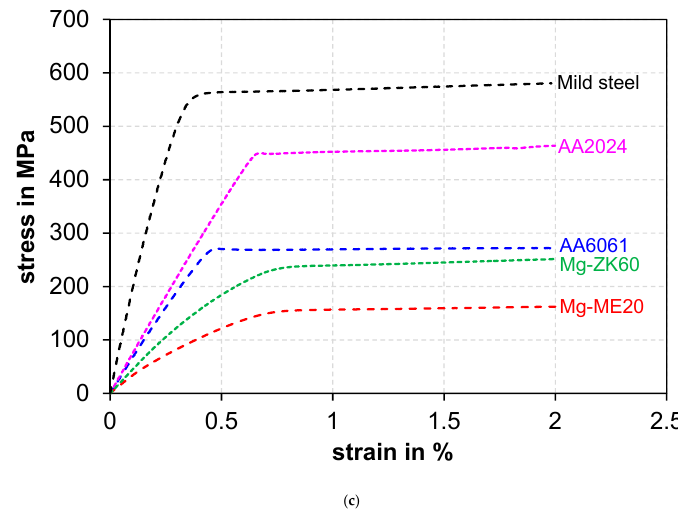
Figure 2. Tensile stress-strain curves after ( a ) position (P) auto-tuning, ( b ) position and load (P + L) auto-tuning, and ( c ) position, load, and strain (P + L + S)